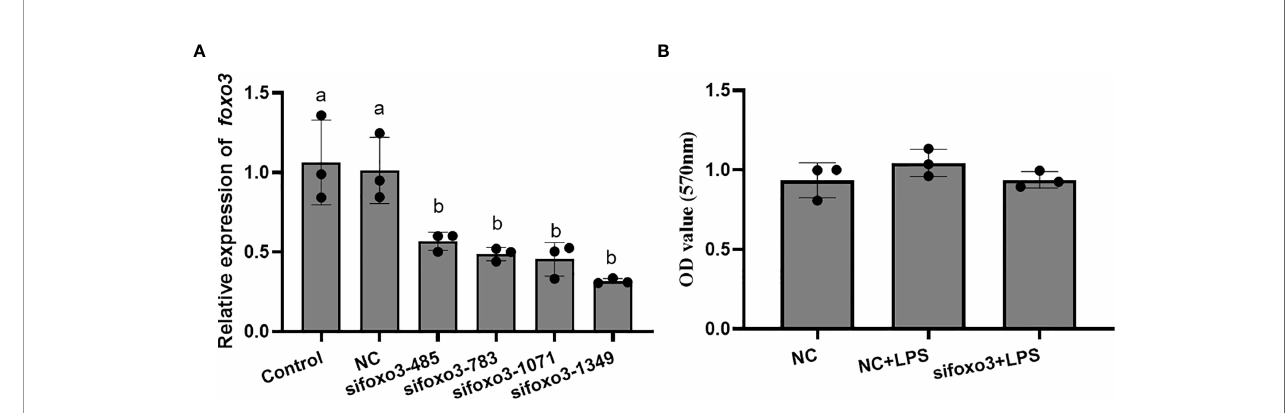
FIGURE 3 | (A) Relative level of foxo3 mRNA in primary cultured hepatocytes treated with si foxo3 . Results are represented as mean ± standard deviation (n = 3). Values with different letters mean signi fi cant differences ( P < 0.05). (B) The OD values of MTT. Results are represented as mean ± standard deviation (n = 3). Values with different letters mean signi fi cant differences ( P <